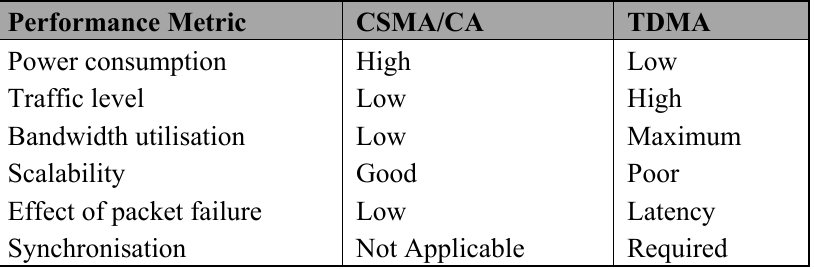
Table 1. CSMA vs . TDMA